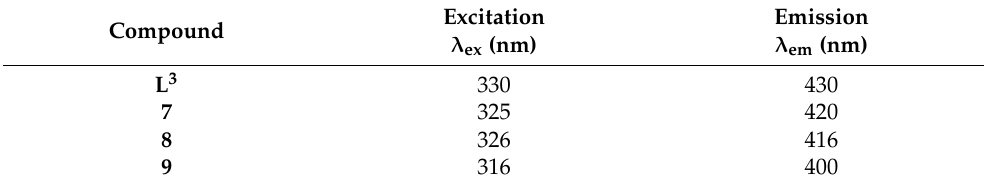
Table 5. Luminescent properties of 7 – 9